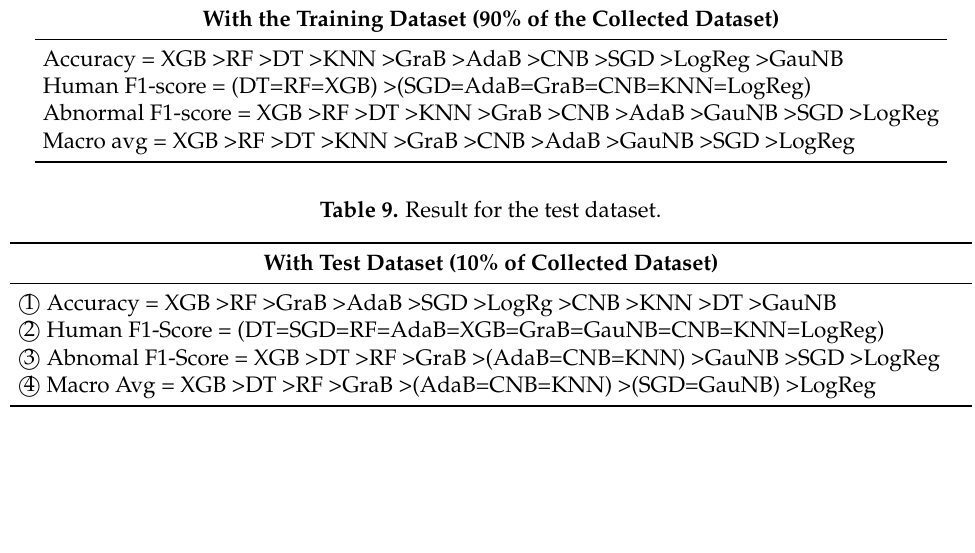
Table 8. Results for the training dataset.